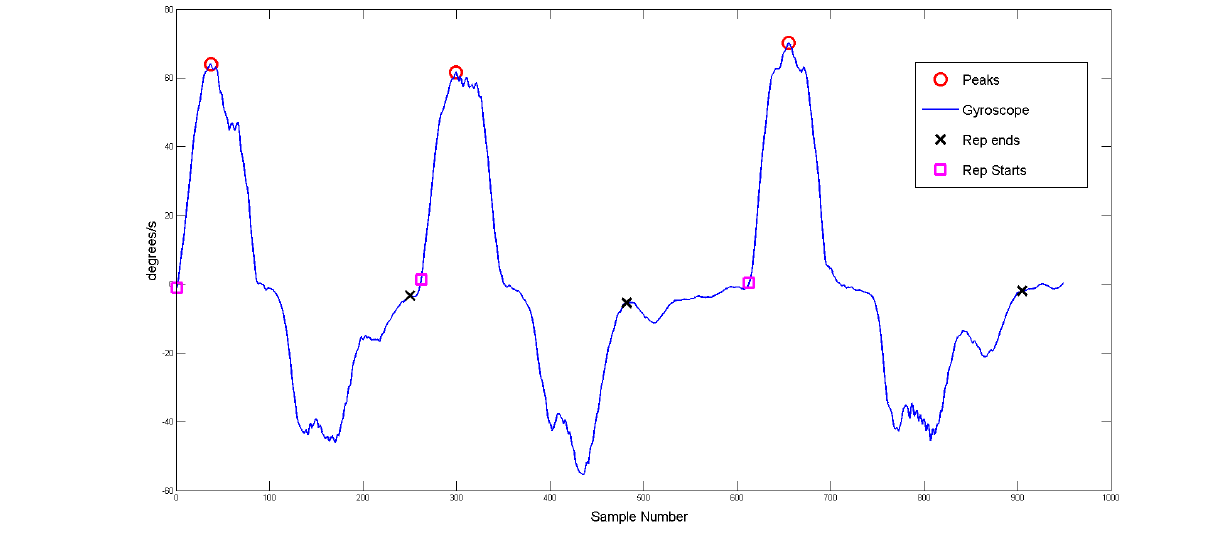
Figure 5. Detection of peak, start, and end points of exercise repetitions (neighboring zero crossing values to the peak locations).